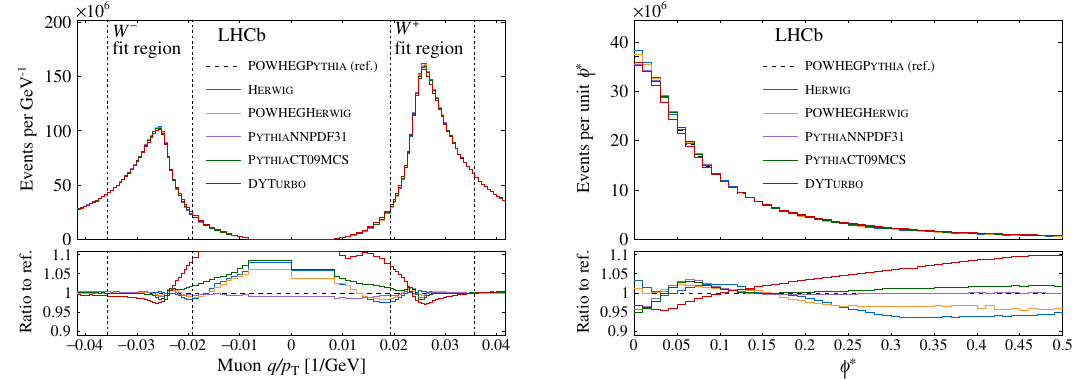
Figure 10 . Projections of the (left) q/p T and (right) φ ∗ distributions for the challenge datasets. The four dashed vertical lines indicate the two fit regions in the q/p